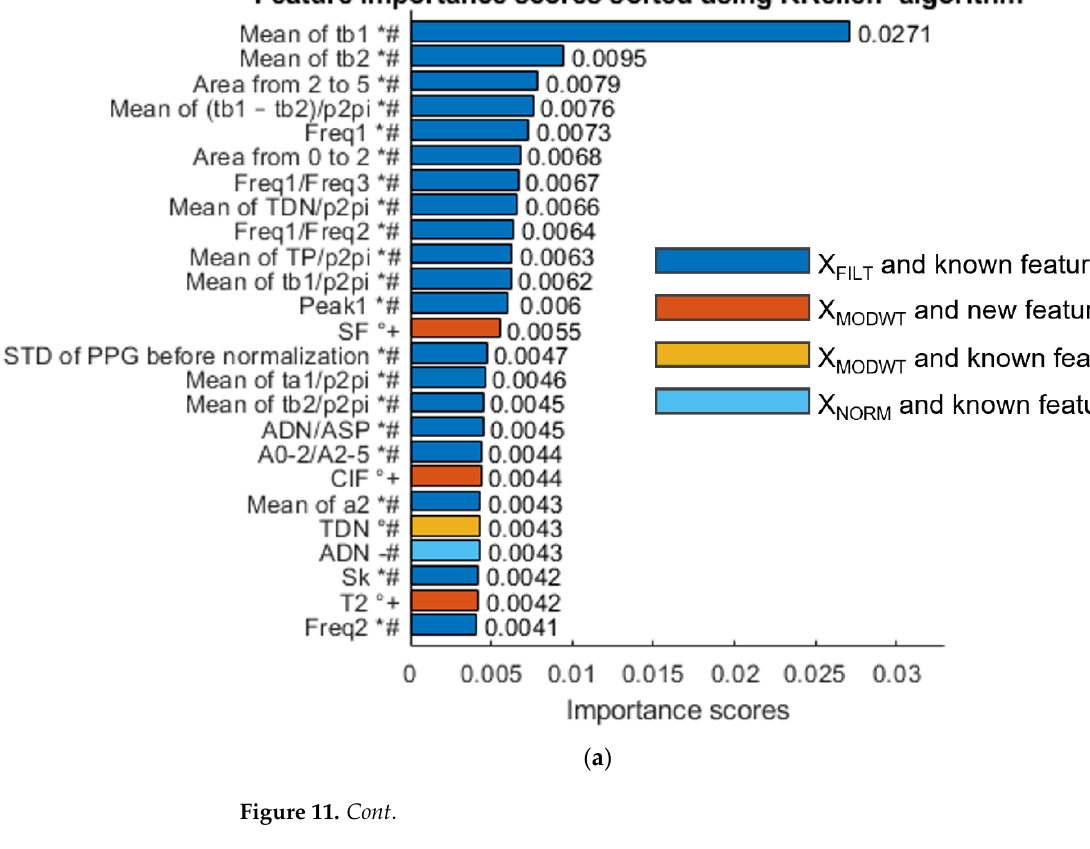
scores sorted using MRMR algorithm for SBP measurement. Feature labels are noted as follows: (*) calculated on 𝑥 𝐹𝐼𝐿𝑇 ( i.e. before MODWT enhancement), (°) calculated on 𝑥 𝑀𝑂𝐷𝑊𝑇 (i.e. after MODWT enhancement), (-) calculated on the normalized signal 𝑥 𝑁𝑂𝑅𝑀 , (+) new feature and (#) al-